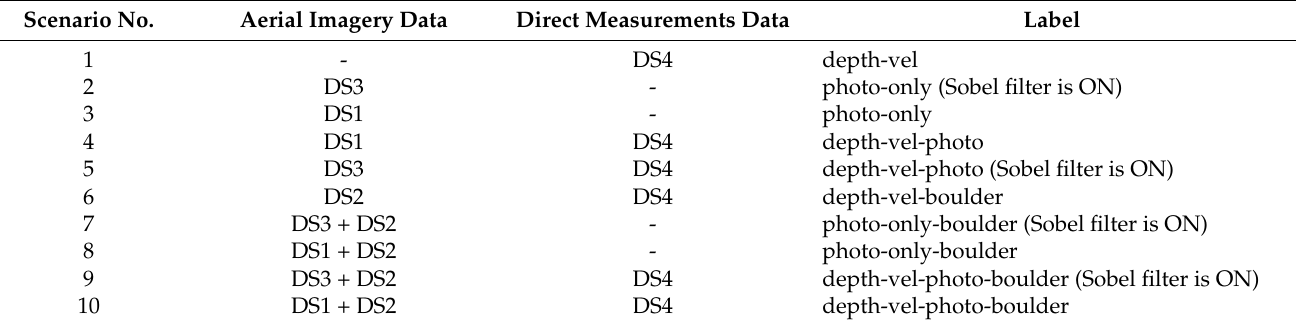
Table 1. Scenarios of models with combinations of input data sources